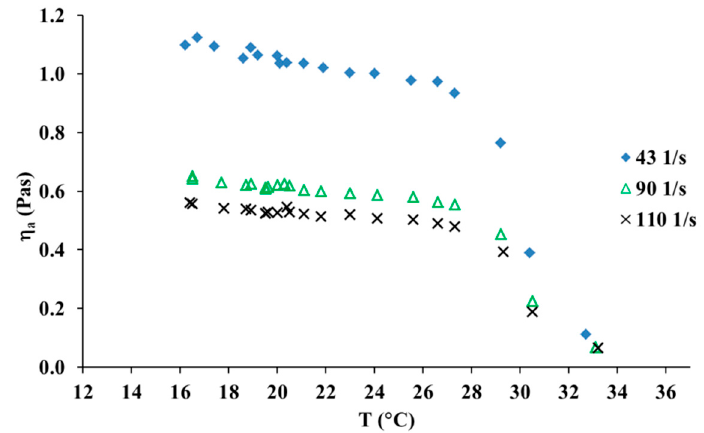
Figure 3. Apparent shear viscosity versus temperature for 10 mg/mL collagen solution at three different shear rates. Table 2. E a value for collagen solution at different shear rates.